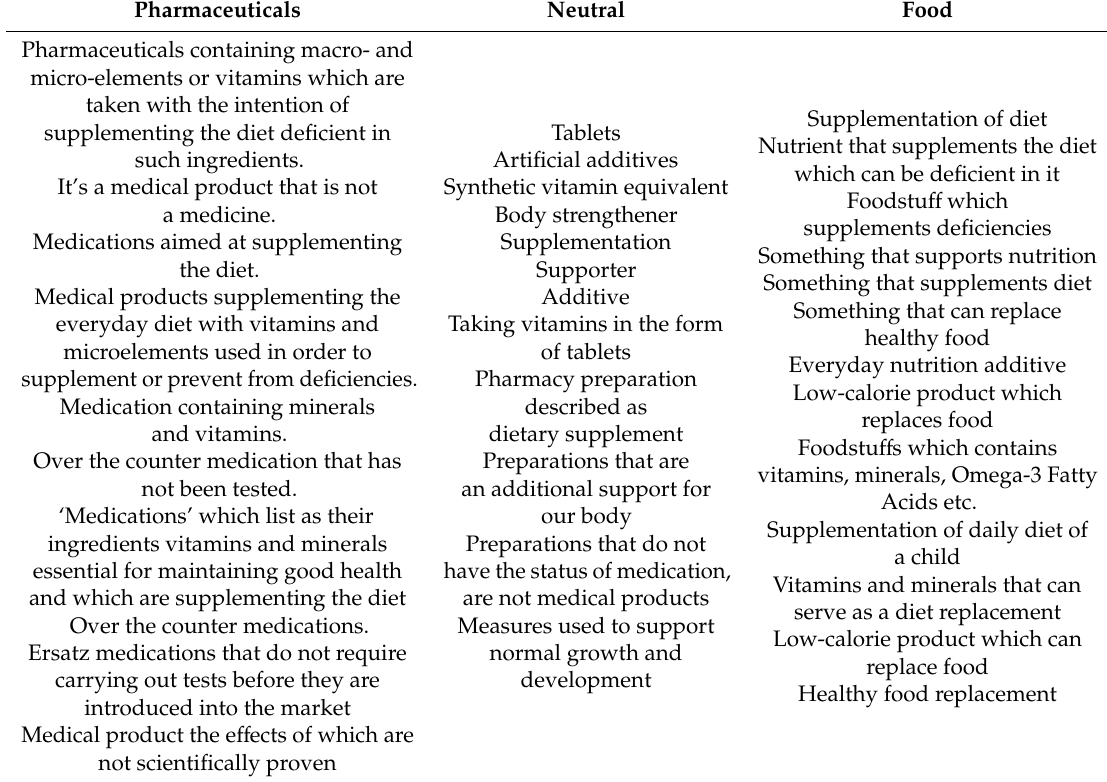
Table 2. Selected definitions of dietary supplements given by the respondents